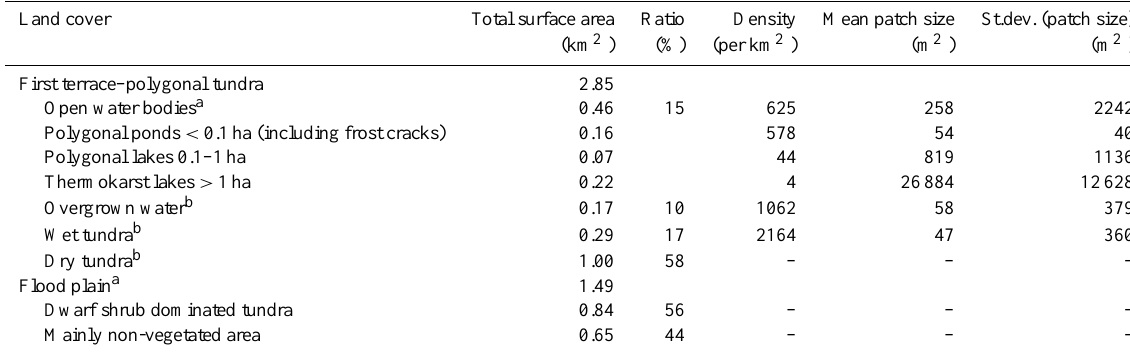
Table 1. Land cover spatial statistics for the mapped area of polygonal tundra on Samoylov Island. Ratio (%) is the percentage of the total mapped area of polygonal